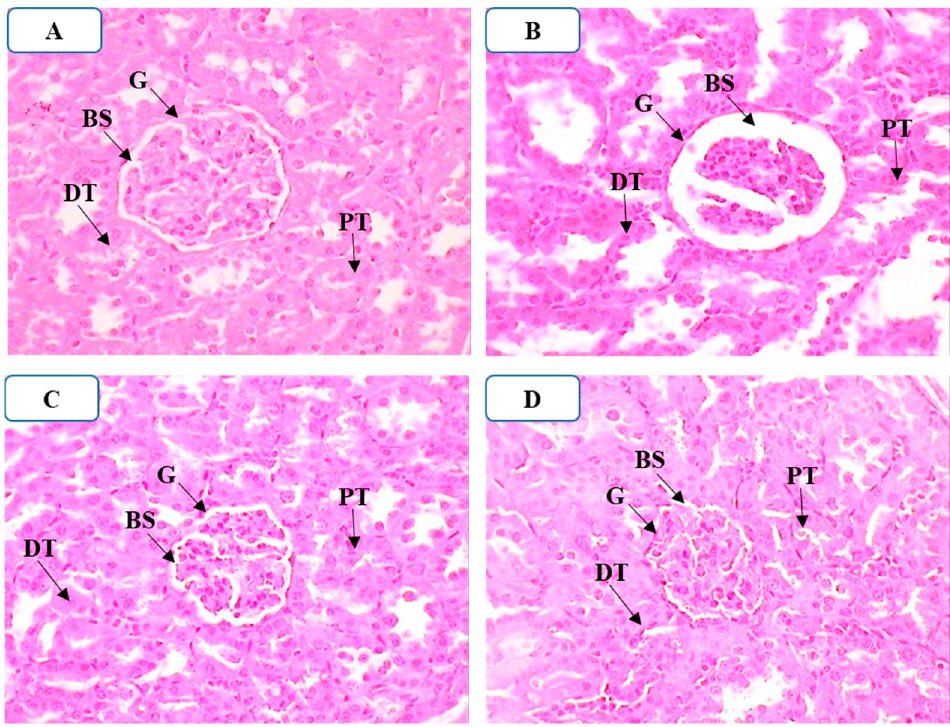
Figure 8. The effect of APTM aqueous extract on renal histology in rats poisoned with GM. Histo- logical sections of renal tissue from different study groups were stained with hematoxylin and eosin and examined under an optical microscope at X40 magnification. ( A ): normal control group, ( B ): GMG (80 mg/kg), ( C ): GGM+TM (200 mg/kg), ( D ): GGM+TM (400 mg/kg), ( G ): Glomerulus, ( DT ): Distal convoluted tubule, ( BS ): Bowman space, ( PT ): Proximal convoluted tubule.